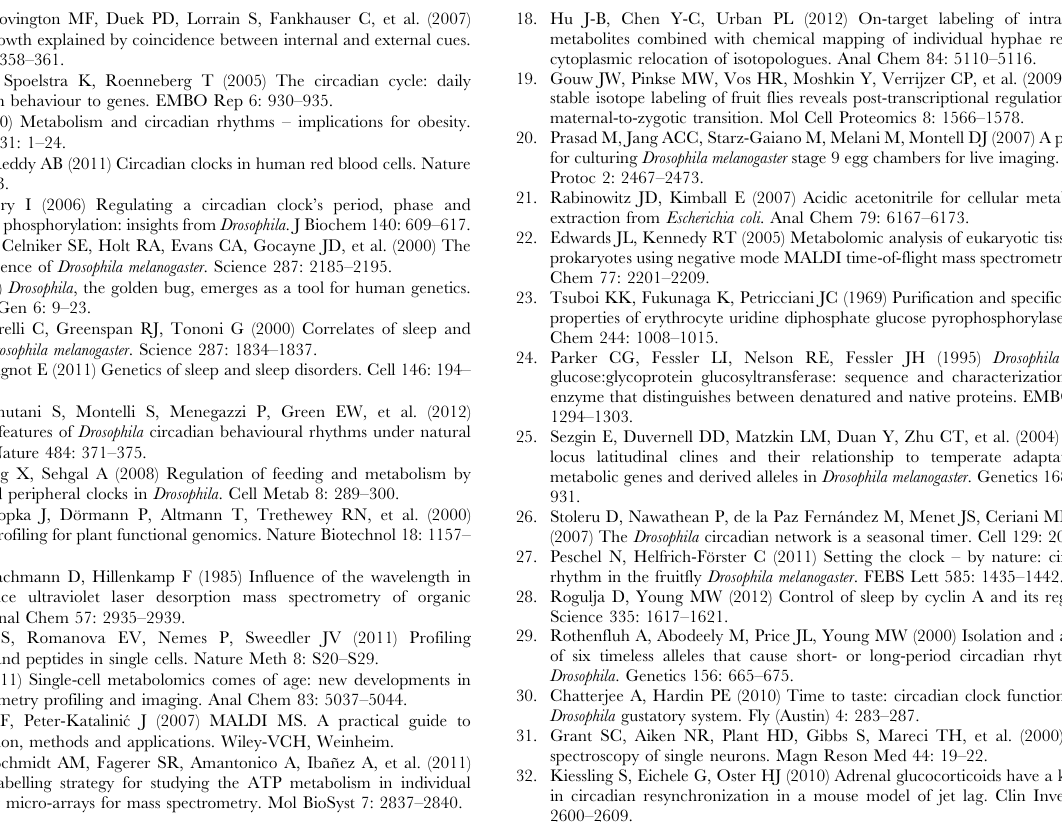
flies incubated during night (starting from the evening) at light; ED –